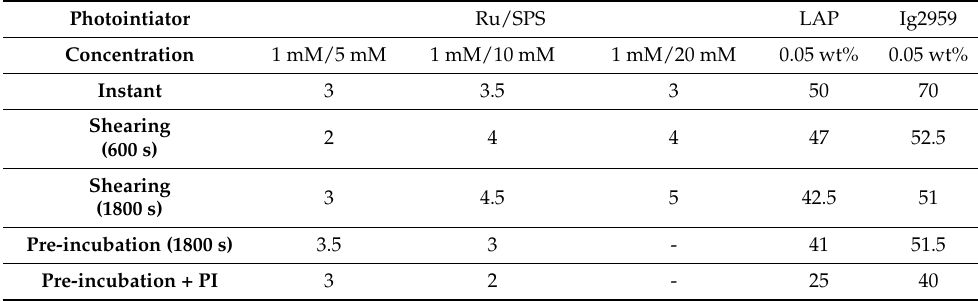
Figure 4. Rheological testing with photocrosslinking: ( a ) variation of storage modulus under irradiation after 60 s stabilization for all the five photoinitiator formulation, ( b ) variation of storage modulus with 1800 s static pre-incubation with and without replenishment of SPS (1 mM/10 mM Ru/SPS), ( c ) compare variation of storage modulus between the condition of 1800 s shearing and 1800 s static pre-incubation (red dash line represents the time to turn of the light for static samples and red solid line represents time to turn of the light for shearing samples), ( d ) variation of storage modulus for LAP under irradiation at different time points and effect of pre-incubation and replenishment of the photoinitiator and ( e ) variation of storage modulus for Ig2959 under irradiation at different time points and effect of pre-incubation and replenishment of the photoinitiator. Note the 1800 s static pre-incubation was performed in the microtube before applied to the rheometer. Table 2. Time to